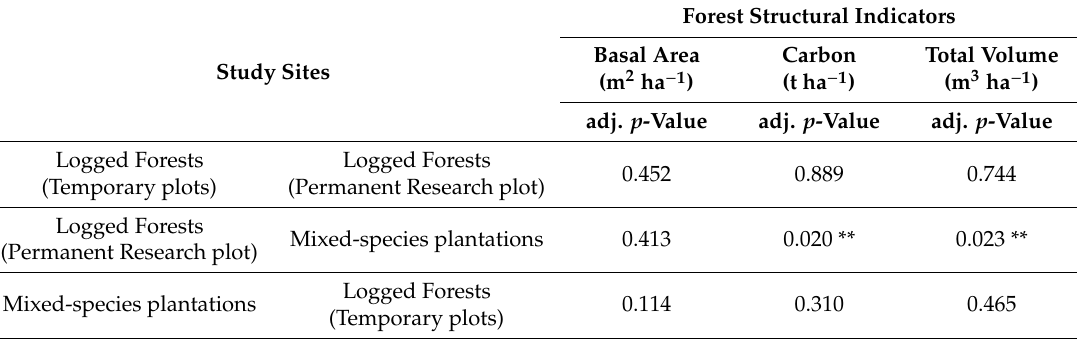
Table 3. Pairwise comparison of the study sites using Tukey HSD test for basal area, carbon stock and volume of the three study sites.